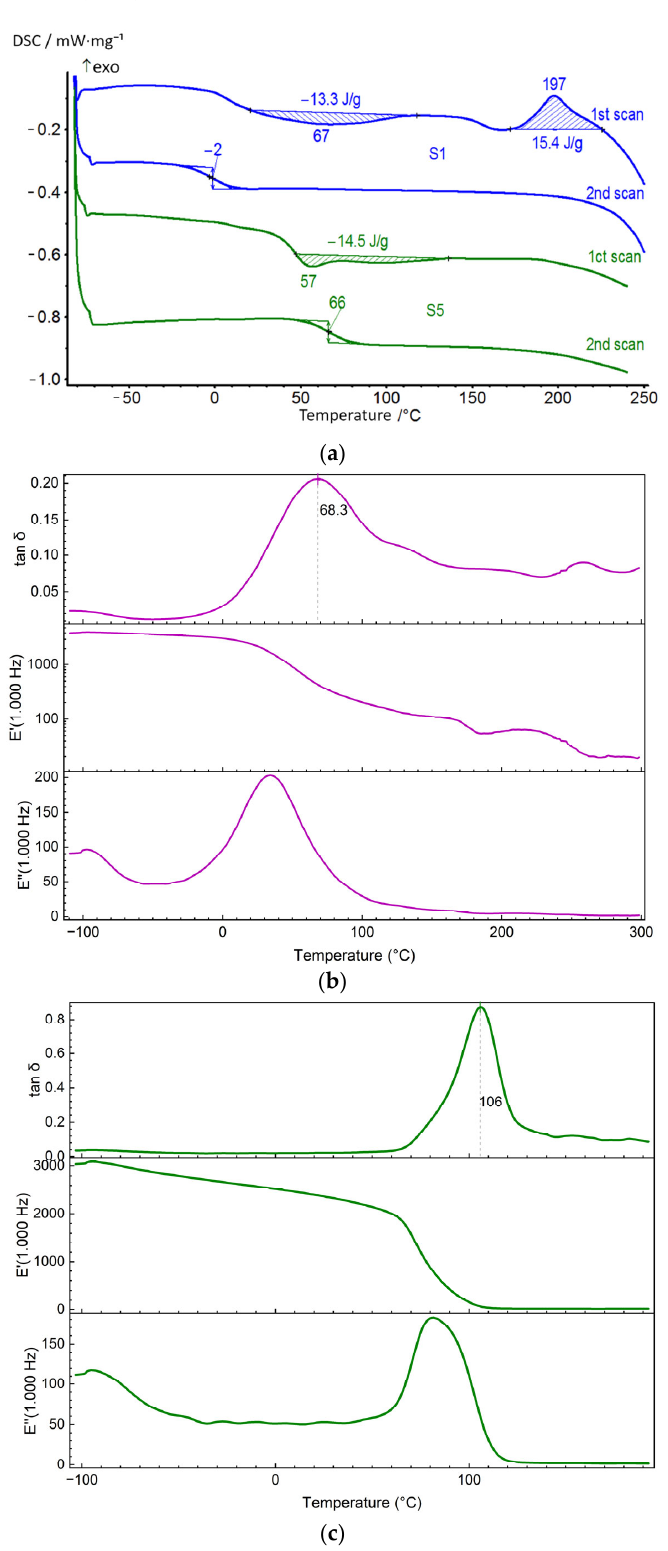
Figure 6. DSC curves ( a ) of the segmented PUU for S1 and S5 and their DMA ( b , c ),